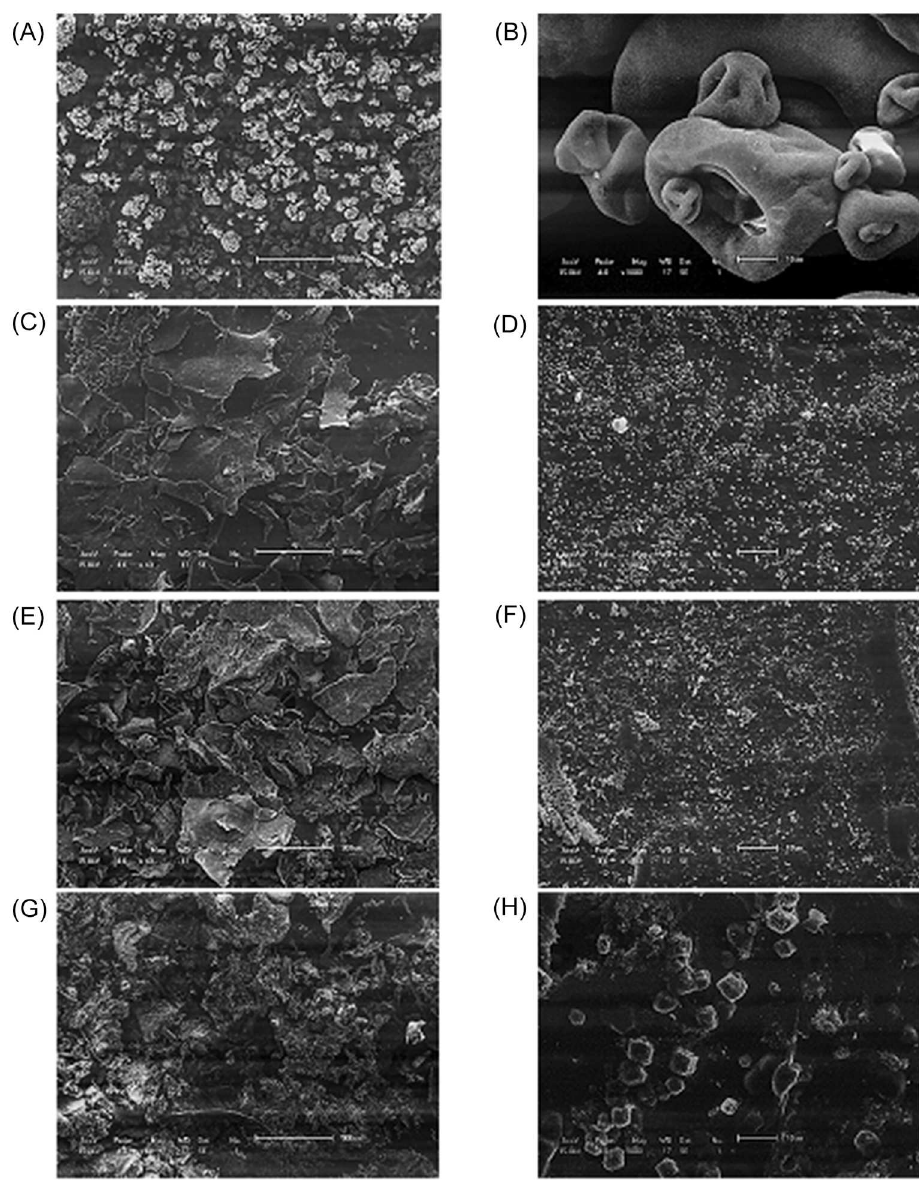
Fig 2. Scanning electron microscopy of: commercialcurdlan—(A) 40x and (B) 1000x magnification; pre-gelled commercialcurdlan—(C) 40x and (D) 1000x magnification; curdlan produced by Agrobacterium sp. IFO 13140 (pre-gelation method)—(E) 40x and (F) 1000x magnification; curdlan produced by Agrobacterium sp. IFO 13140 (precipitation method)—(G) 40x and (H) 1000x